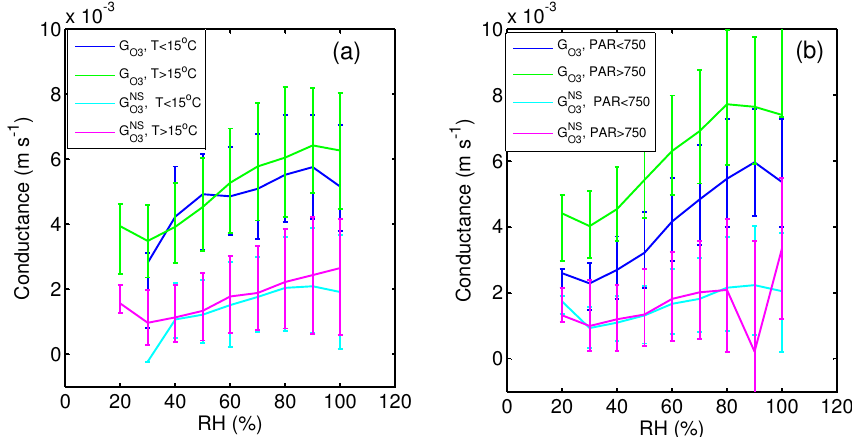
Fig. 5. Day-time (elevation angle of sun>10 ◦ ) ozone conductance as a function of RH during weeks 25–34. 15 ◦ C and 750µmolm − 2 s − 1 were used as the values to separate high and low temperature (a) and PAR (b) conditions. Medians of 30 min average observations together with quartiles are presented.